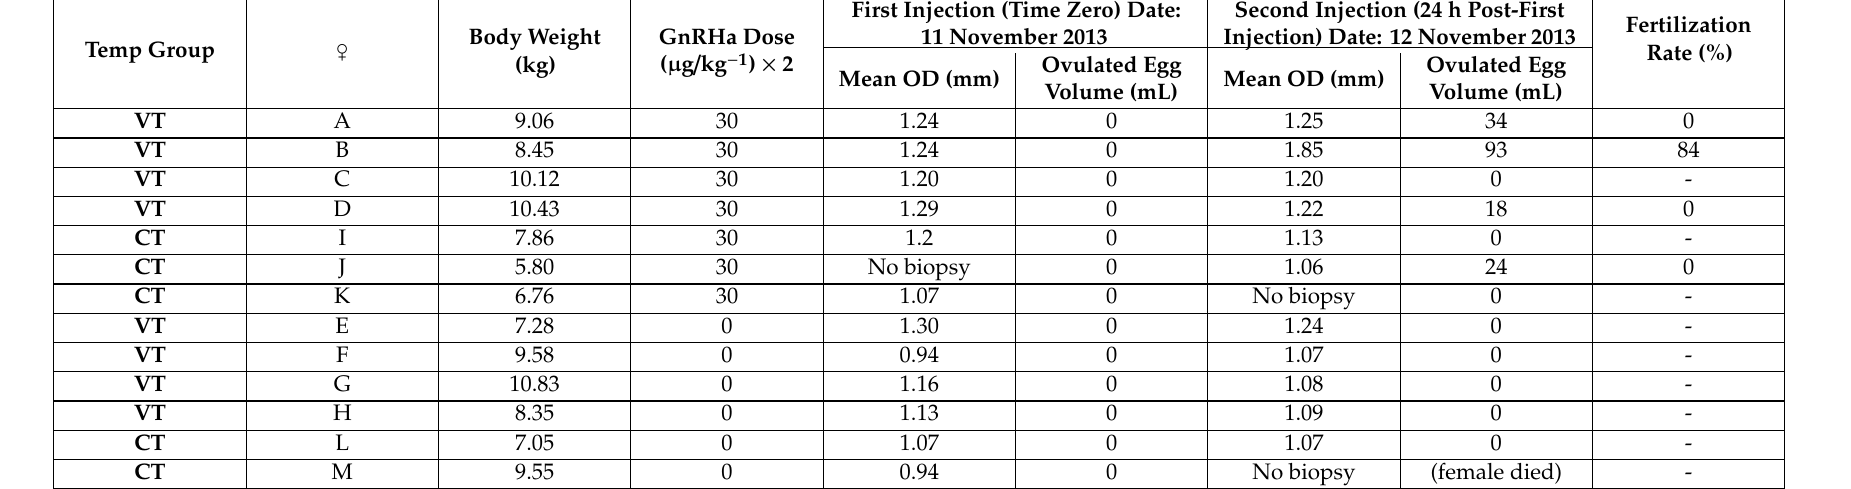
Table 1. Summary of the number of first filial (F1) h¯apuku ( Polyprion oxygeneios ) in each temperature group and the IM injection treatments of fish subjected to strip-spawning during the 2013 spawning season. Gonadotropin-releasing hormone (GnRHa) pre-treated females from both temperature groups received two